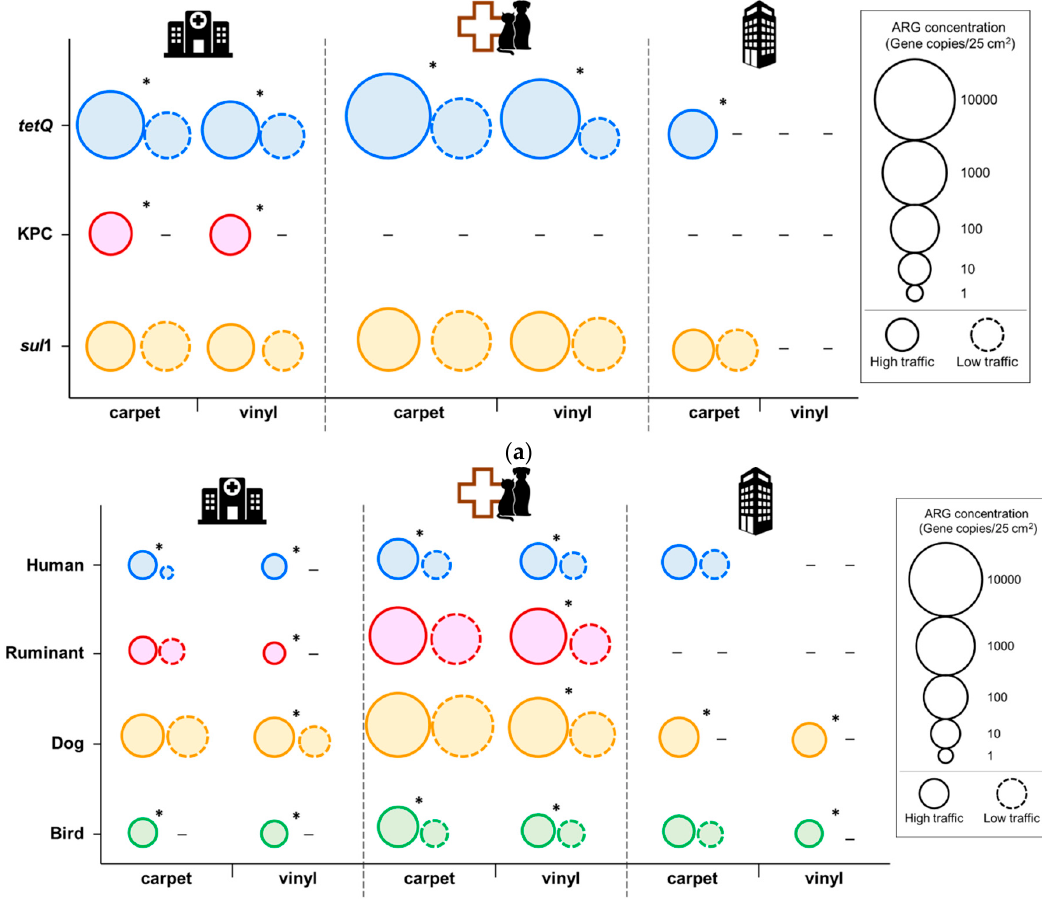
Figure 1. Concentrations of antibiotic resistance (tetracycline, sulfonamide, and KPC) ( a ) and fecal bacteria from human (HF183), ruminant (Rum2Bac), dog (BacCan), and bird (GFD) ( b ) in floor samples from each type of building (medical center, veterinary hospital, and o ffi ce). * Statistically significant di ff erence between the high and low tra ffi c areas ( p < 0.05)—Not